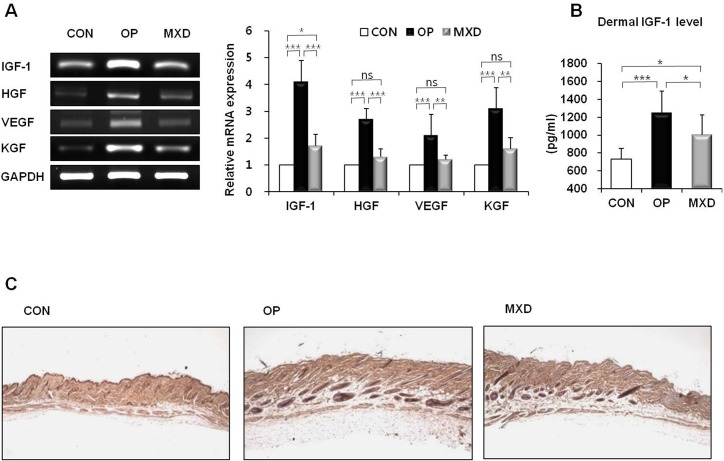
Effect of oleuropein on mRNA and protein expression of growth factors in C57BL/6N mouse skin tissue.(A) The IGF-1, HGF, VEGF, and KGF mRNA expression levels were measured by RT-PCR. A representative image of triplicate experiments is shown in the left panel. The right panel shows the intensity of the bands that were densitometrically measured and normalized against the mRNA expression level of GAPDH. (B) Dermal levels of IGF-1 were assessed by ELISA. (C) Immunohistochemical analysis of IGF-1 expression in hair follicle. Original magnification: 40×. The RT-PCR results are the mean (n = 8) ± SD of three independent experiments (n = 2 or 3 per experiment) for each group. ns = p > 0.05, * = p < 0.05, ** = p < 0.01, *** = p < 0.001 (one-way ANOVA, Tukey's test).